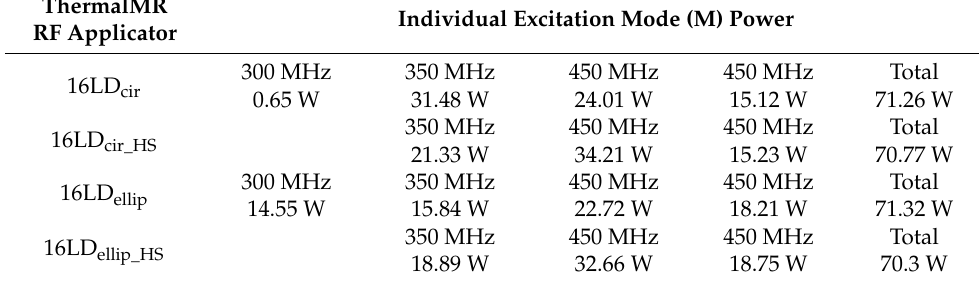
Table 1. Input power for temperature simulation from individual excitation mode (M) power obtained from targeted RF heating optimization for 16LD thermalMR RF applicators.